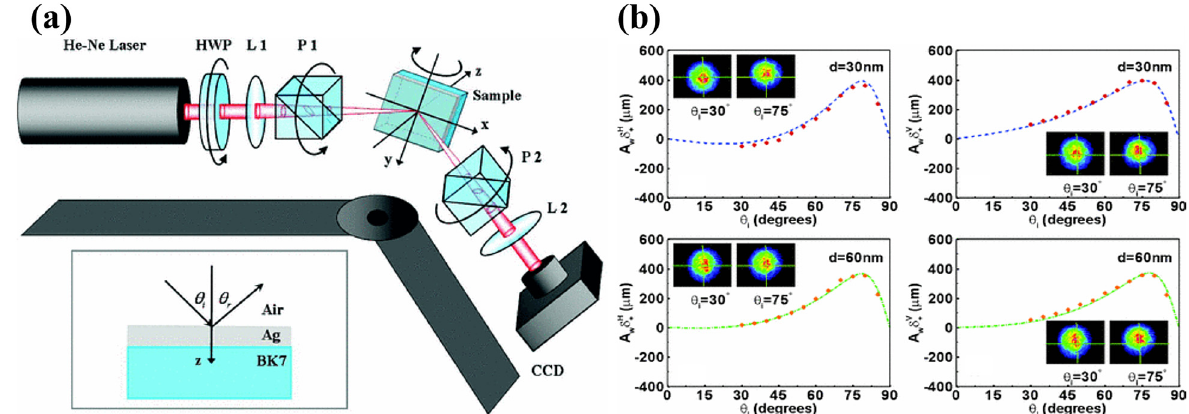
Figure 10: a, PSHE in Archimedes spiral structure[82];b,chiralSHGfrommonolayer WS 2 /Al plasmonic vortex structure [82].